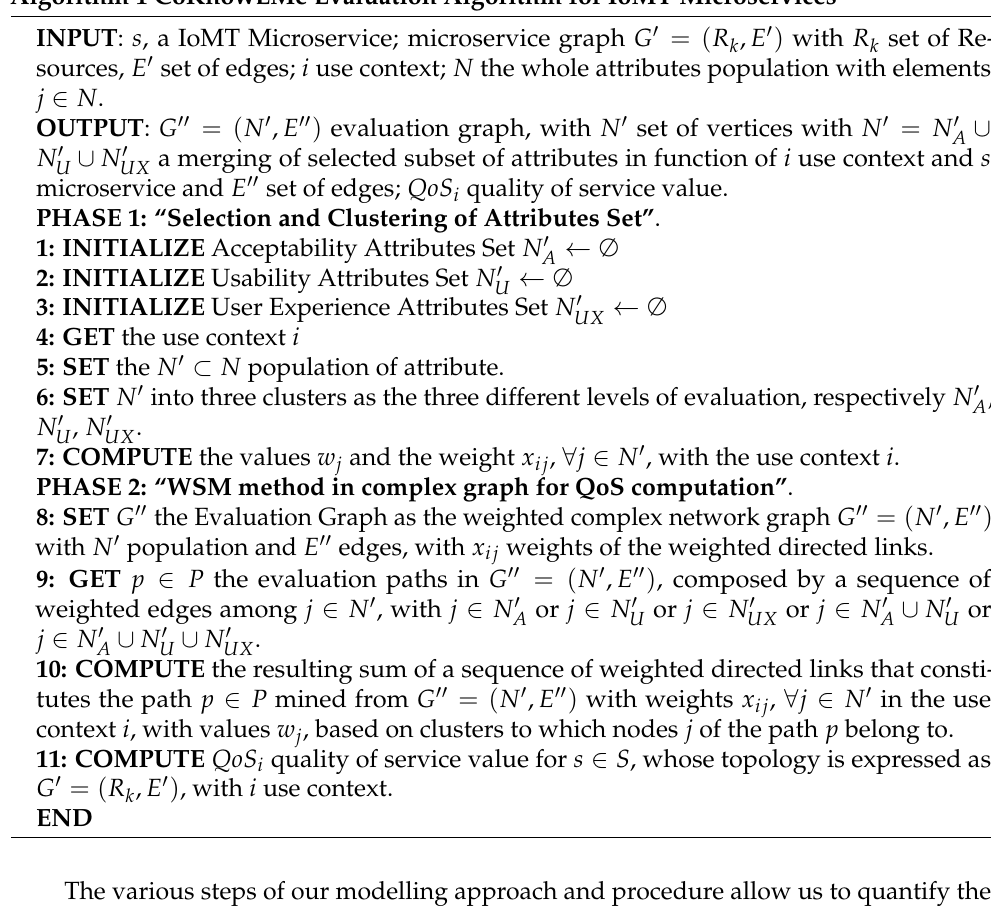
Algorithm 1 CoKnowEMe Evaluation Algorithm for IoMT